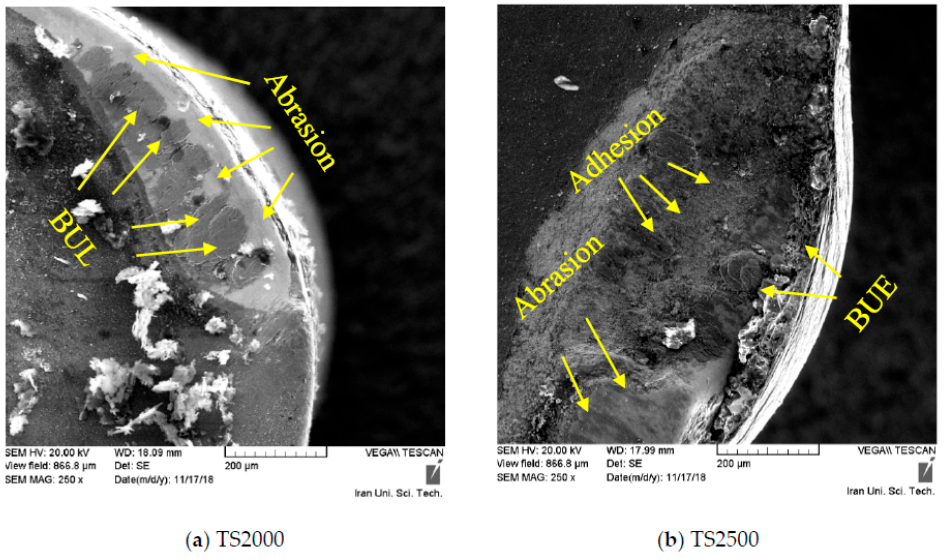
Figure 5. Wear modes in both inserts after 60 s of cutting.